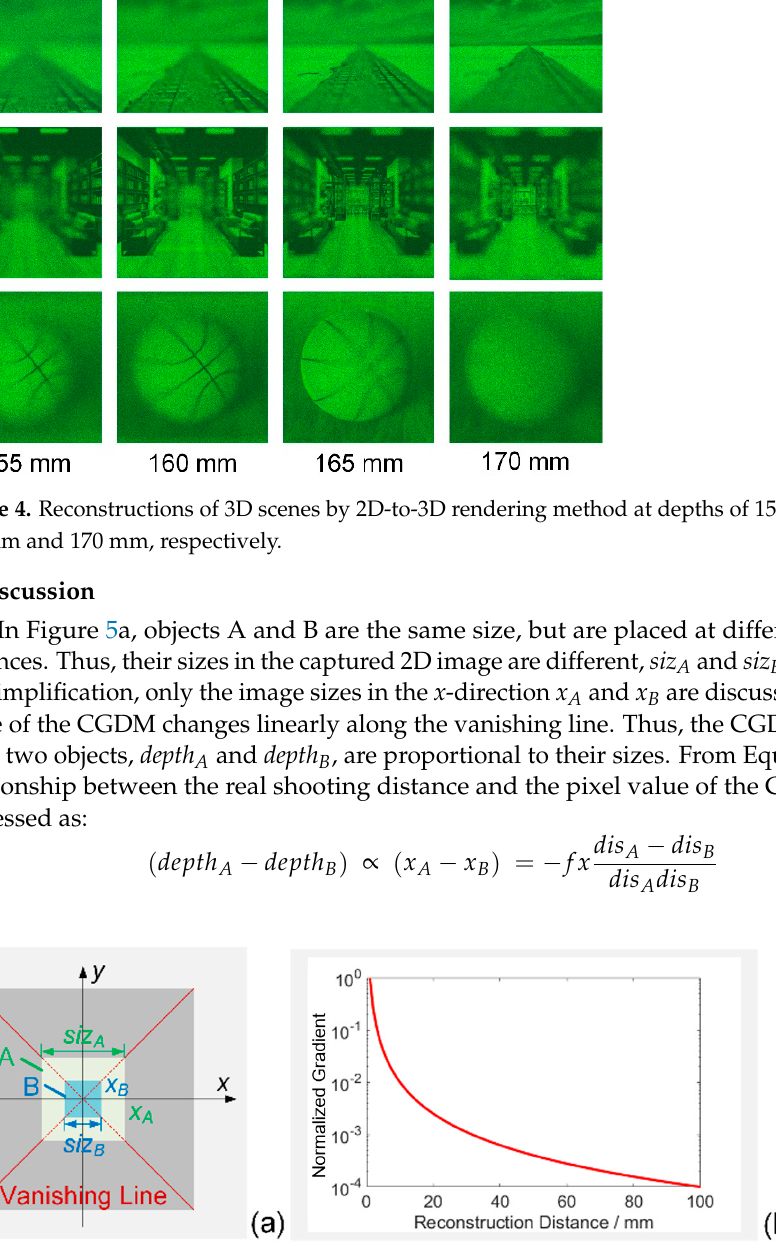
Figure 5. The relationship between shooting distance and gray scale in CGDM. ( a ) Variation of CGDM with shooting distance (same size objects). ( b ) Normalized gradient of CGDM variation with shooting distance.